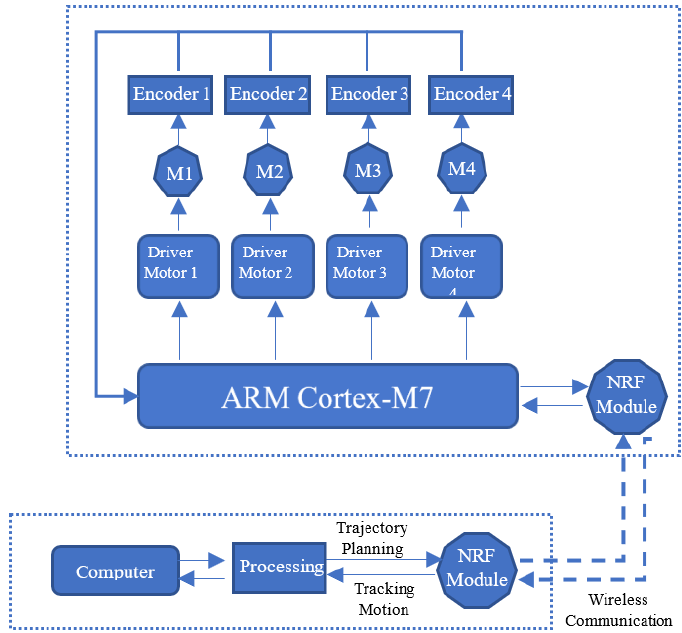
Figure 9. Electronic Wiring Diagram.